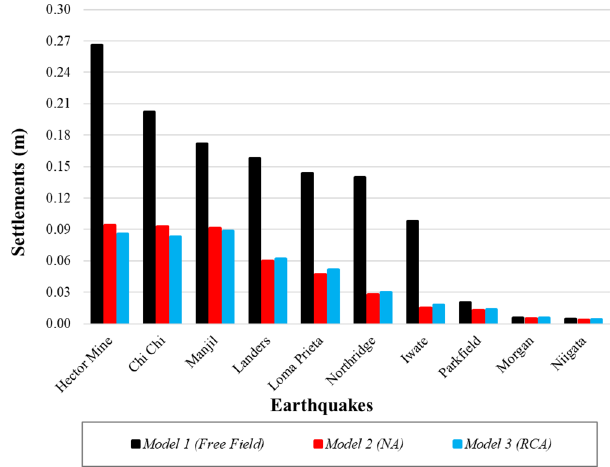
Figure 22. Liquefaction-induced settlement for Model 1, 2 and 3.